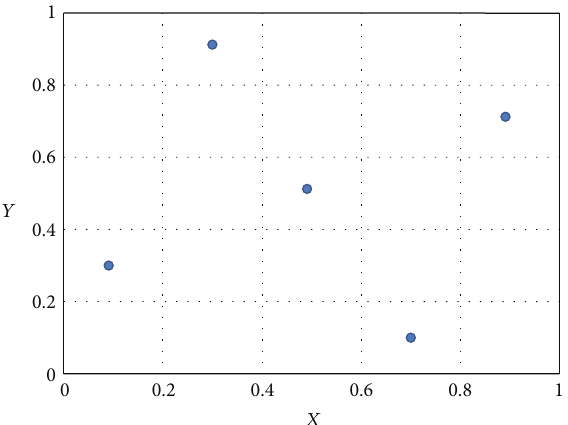
Figure 2: A scatter plot about expression data of probe sets 𝑋 and 𝑌 with fixed intervals to divide the axes into discrete bins. Dataset = [(0.1, 0.3),(0.3, 0.9),(0.5, 0.5),(0.7, 0.1),(0.9, 0.7)]